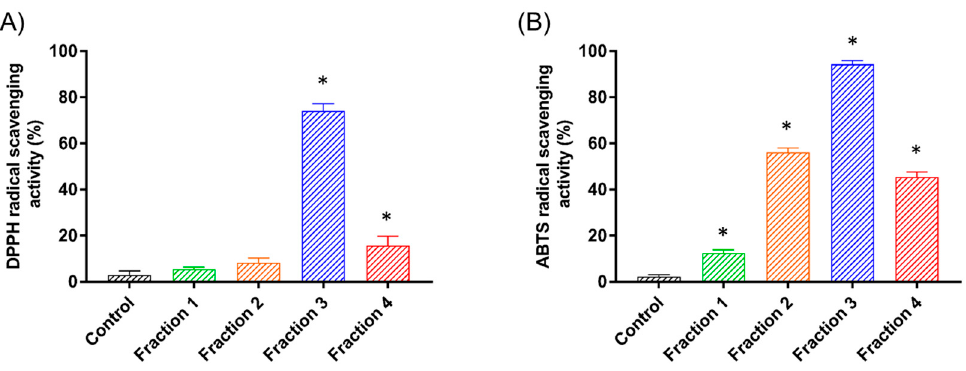
Figure 2. Antioxidant activity of the major peptides fractions isolated Geoffroea decorticans seeds. ( A ) DPPH radical-scav- enging activity. ( B ) ABTS radical-scavenging activity. The vertical bars correspond to the standard deviation. Fractions 1–4 were used at the same concentration. * p < 0.05, compared to DPPH/ABTS control reactions (control) without sample.